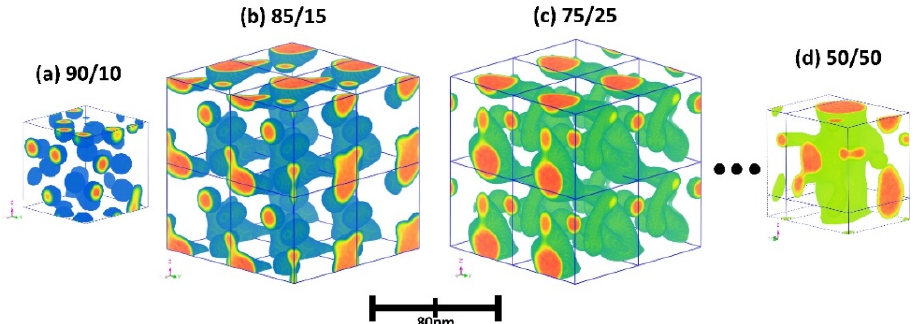
Figure 8. The mesoscopic simulation of the polymer blend with various amounts of s-P6F9CB ( a ) 10% ( b ) 15% ( c ) 25% ( d ) 50%, where colors show the isopycnic surfaces of s-P6F9CB and stack boxes for visualization. The unit box is 40 nm × 40 nm × 40 nm.